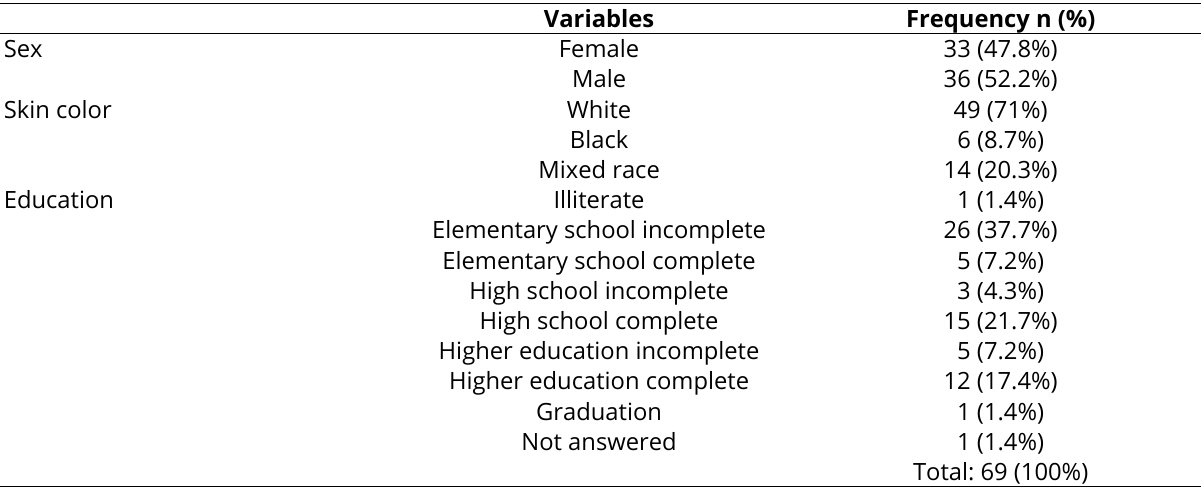
Table 1 – Sociodemographic characteristics of patients with Dermatofibrosarcoma at Barretos Cancer Hospital.